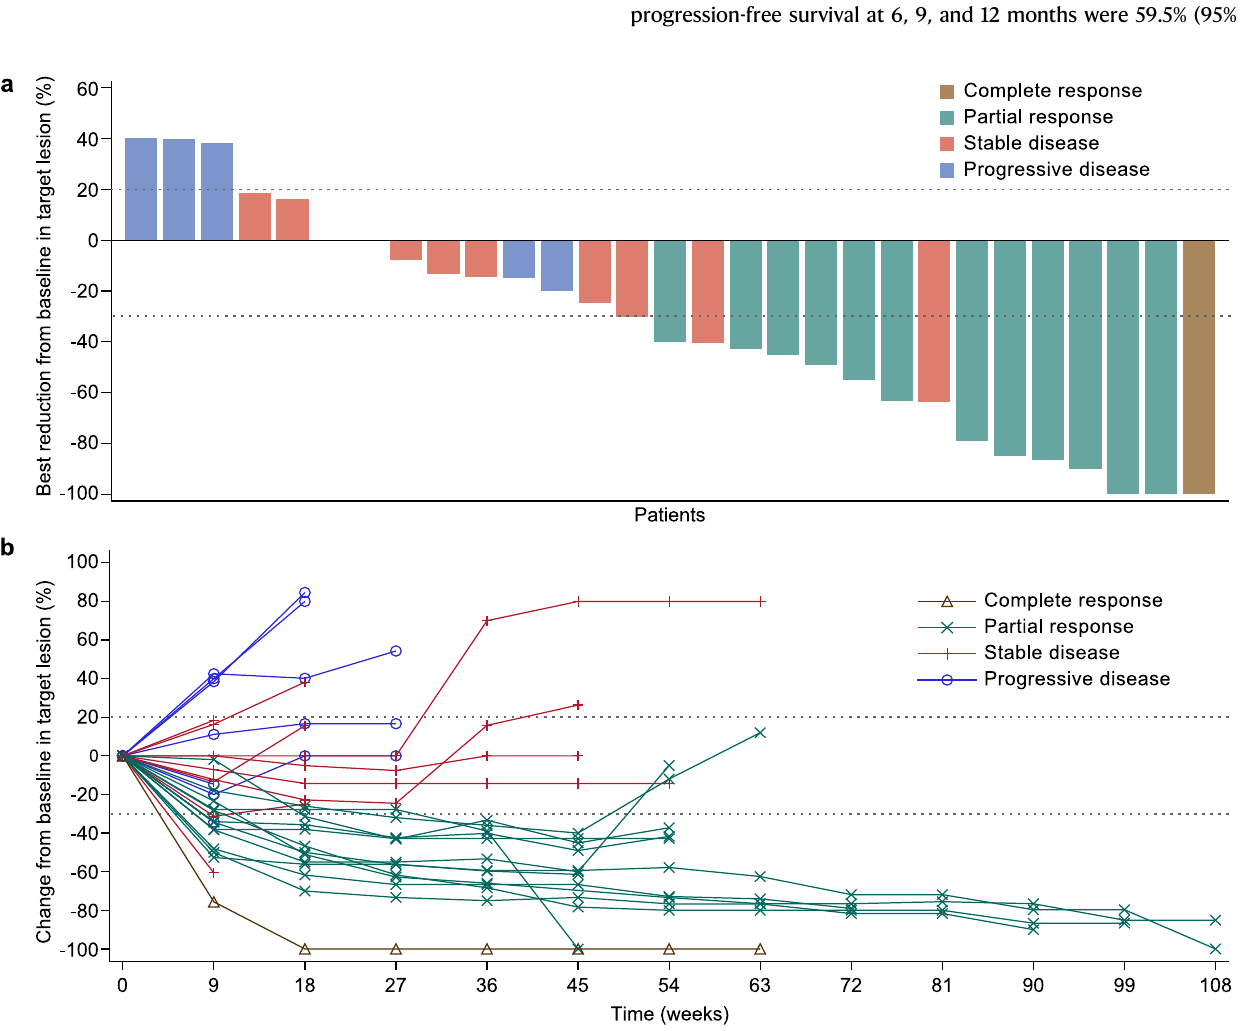
Fig. 1 | Tumor responses after camrelizumab plus famitinib treatment. a Waterfall plot demonstrating the best percentage changefrom baseline in target tumorlesionsize.Eachbarrepresentsapatient.Thedashesindicatea20%increase or30%reduction. b Spiderplotpresentingthepercentagechangefrombaselinein target tumor lesion size over time. The waterfall and spider diagrams showed the